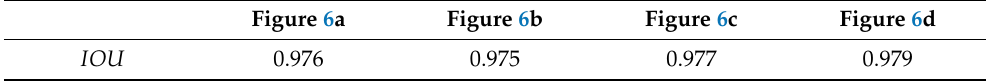
Table 3. 𝐼𝑂𝑈 of each Inversion image when 𝐼𝑛𝑣𝑒𝑟𝑠𝑖𝑜𝑛 𝑅𝑎𝑡𝑖𝑜 =1:10.